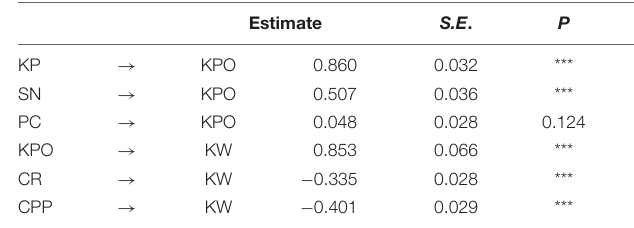
TABLE 3 | Structural equation path test